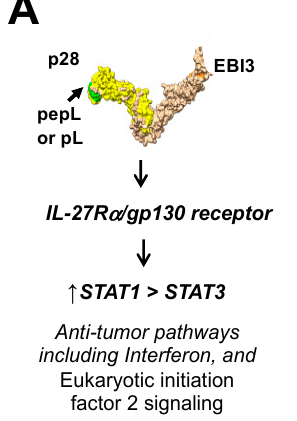
Figure 1. Overview of the IL-27pepL features. ( A ) Schematics of IL-27pepL functions. ( B ) Modeling and alignment of the prototype IL-27pepL containing 1 Gly4Ser (G4S) linker or current version with 2xG4S linker with the pepL in the pL1 (prototype) or pL2 (current) conformations, using iTASSER and Chimera. ( C ) Expression levels by qPCR of the IL-27pL transgene in C2C12 muscle cells comparing the traditional vector pcDNA3.1 and the new pORF9 vectors (lacking an insert ( − ) or with the IL-27pL insert) generated in this study. *, p < 0.05 relative to vector lacking insert, and #, p < 0.05 relative to the pcDNA3.1-IL-27pL group.